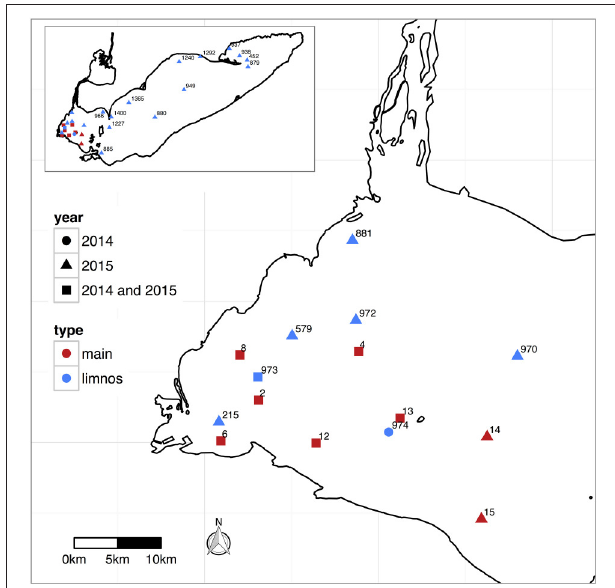
FIGURE 1 | Stations sampled in Lake Erie during 2014 and 2015 identified by site ID number, with “main” corresponding the stations sampled weekly during summer 2014 and 2015, and “limnos” corresponding to the stations sampled on the CCGS Limnos cruises during August and September 2014 and August and October, 2015.